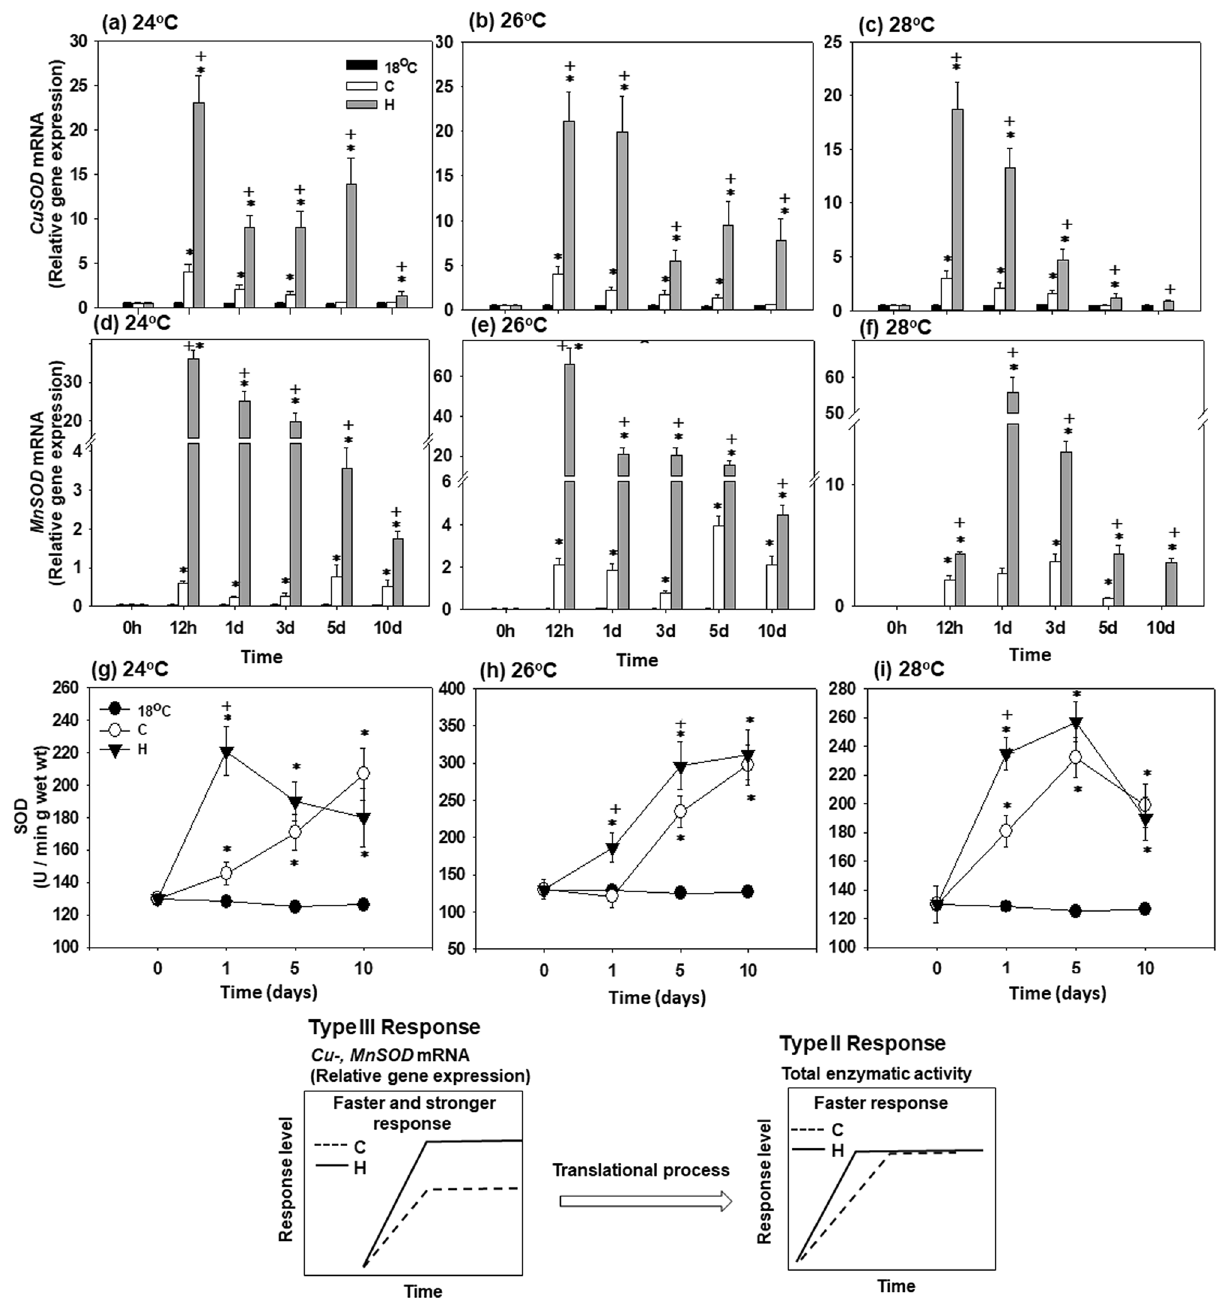
Figure 3. Changes in the relative CuSOD and MnSOD mRNA levels [Type III (stronger) response], and SOD enzymatic activity [Type II (faster) response] in the mantle of heat hardened (H) and non-hardened (C) Mytilus galloprovincialis when exposed to 24 °C ( a , d , g ), 26 °C ( b , e , h ) and 28 °C ( c , f , i ) compared to control at 18 °C. Values are means ± SD, n = 8 preparations from different animals. * p < 0.05 compared to day 0, + p < 0.05 compared to non-hardened (C)